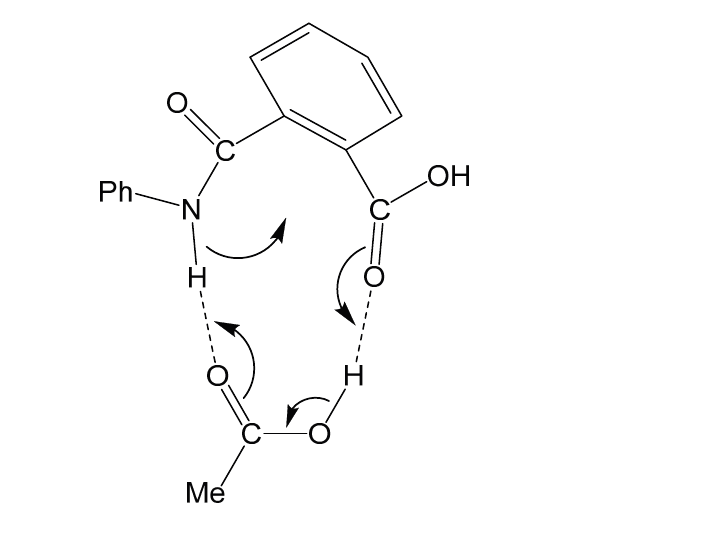
Figure 9. The transition vectors of ( a ) TS1 (the first-step transition state, Figure 4) and ( b ) TS2 (the second-step transition state, Figure 7).